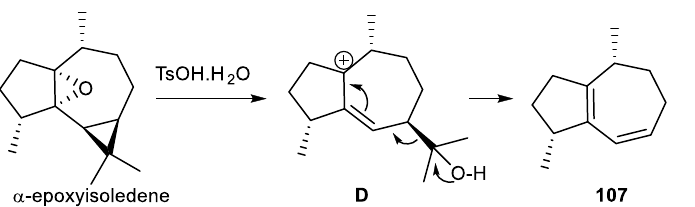
Figure 19. Treatment of α -epoxyisoledene with TsOH.H 2 O in acetone yielding tri- nor -guiadiene.